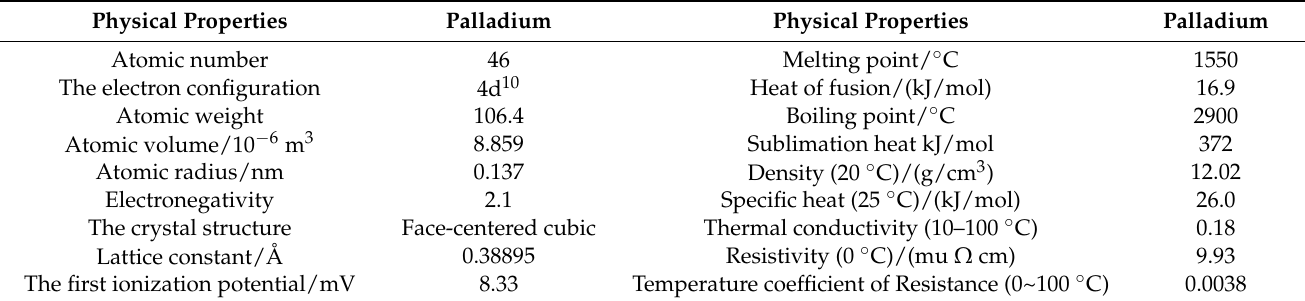
Table 2. The detailed physical properties of